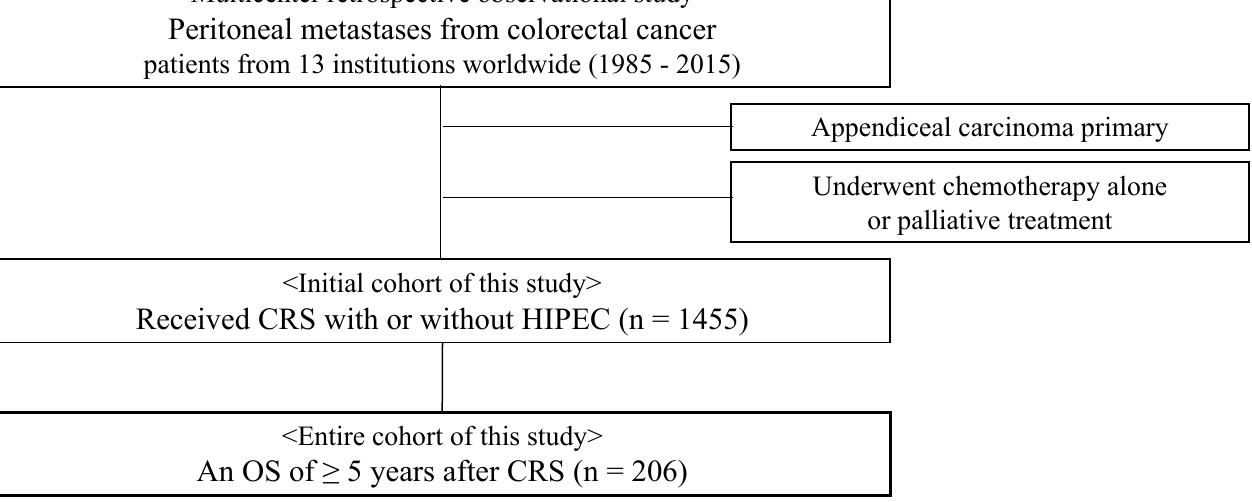
Table 1. Baseline